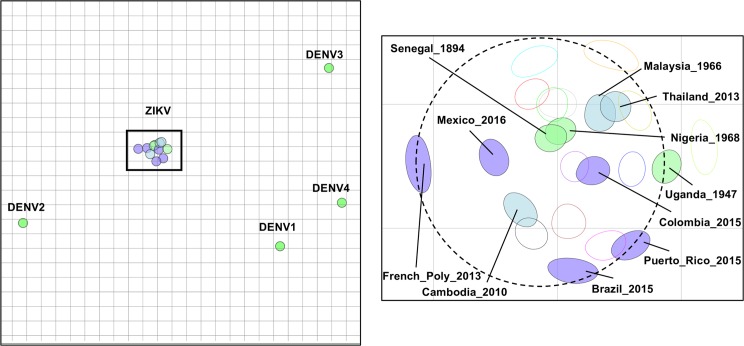
Antigenic map of eleven ZIKVs against twelve human ZIKV immune sera from 5 to 38 months post-infection.Locator map shows the relative antigenic relatedness between ZIKV and the dengue viruses. Each unit of antigenic distance (AU), the length of one side of a grid square, is equivalent to a two-fold dilution in the neutralization assay. Inset map shows each serum and ZIKV. Sera are shown as open blobs colored to match each serum as in Fig 2. Each virus is shown as a filled blob and is colored according to virus strain (American = slate blue, African = turquoise, Asian = steel blue). The size and shape of each blob is the confidence area of its position. Dashed line circle has a diameter equal to 2 AU or four-fold, the difference of a single dilution in the FRNT assay used to estimate FRNT50 titer.